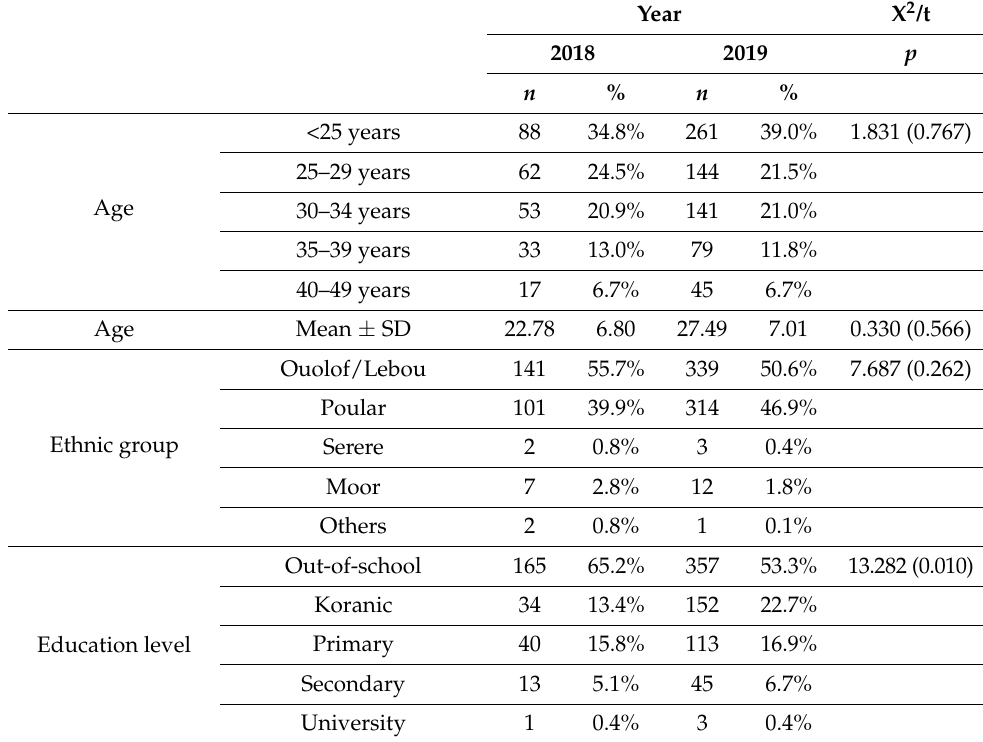
Table 1. Characteristics of the participants